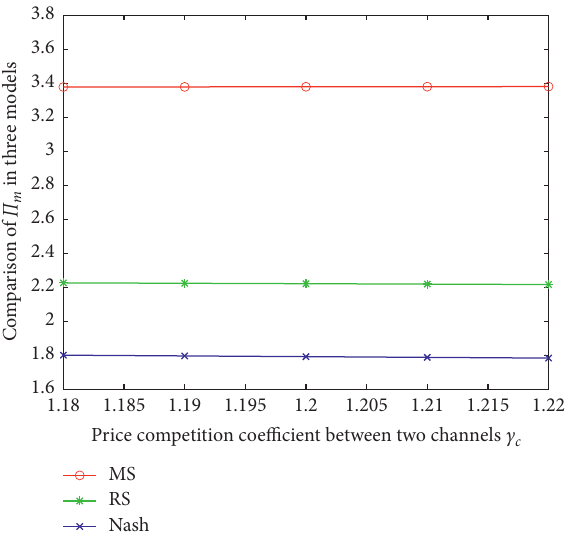
Figure 13: The comparison of the manufacturer’s profit Π three